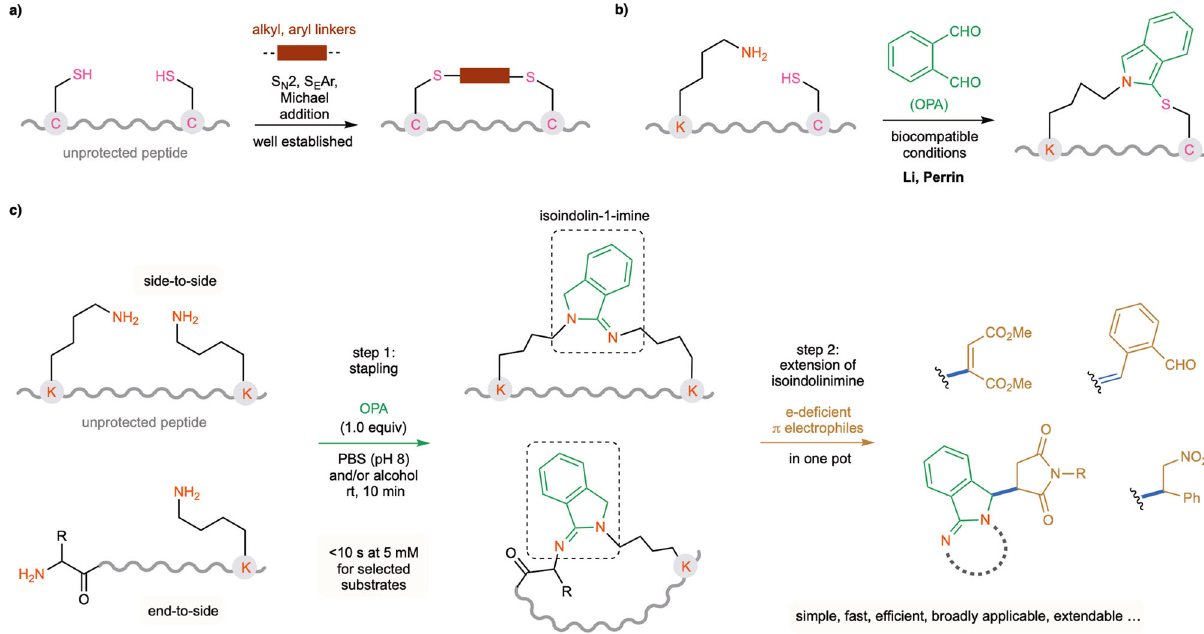
Fig. 1 Stapling of unprotected peptides via non-Cys residues under mild aqueous conditions. a Common strategies for peptide stapling via two cysteine residues. b OPA-mediated peptide stapling via cysteine and lysine residues. c OPA-mediated peptide stapling via two amine groups (this work). C: cysteine, K: lysine. The thiol group of cysteine is marked in magenta. The amino group is marked in red. The linkers joining the two cysteines are marked in cayenne. The OPA reagent and isoindolinimine core are marked in green. The π electrophiles are marked in mocha. The linkages between isoindolinimine and electrophiles are marked in